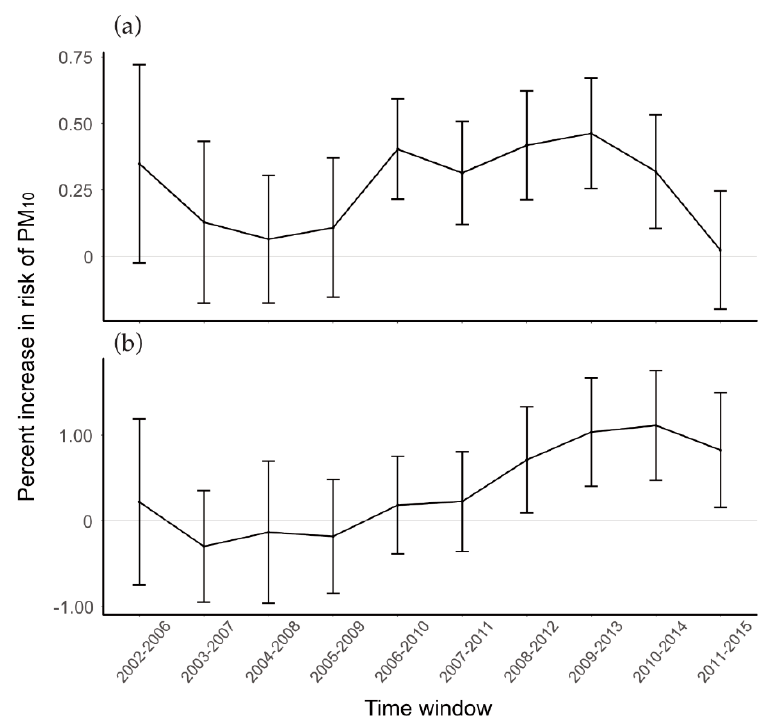
Figure 3. Temporal trend of PM 10 effects on hospital outpatients due to stroke in seven major cities of Korea, 2002–2015. ( a ) Hospital outpatients admitted for ischemic stroke; ( b ) hospital outpatients admitted for hemorrhagic stroke.